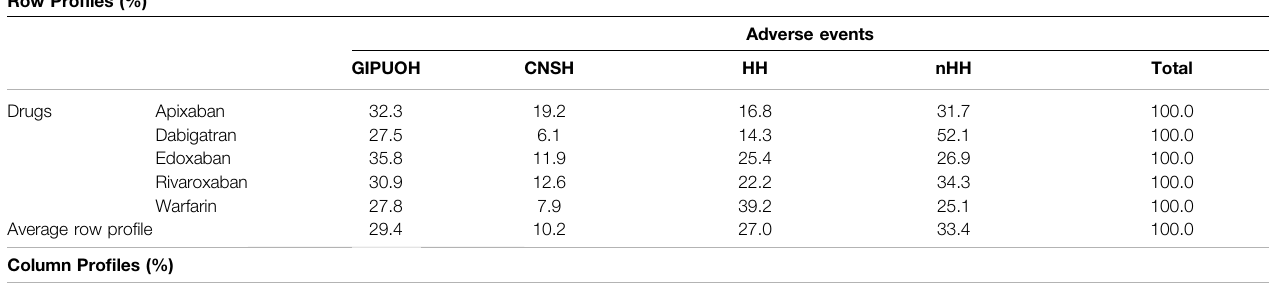
TABLE 3 | Row and column pro fi les of drugs and AEs. Row Pro fi les (%)